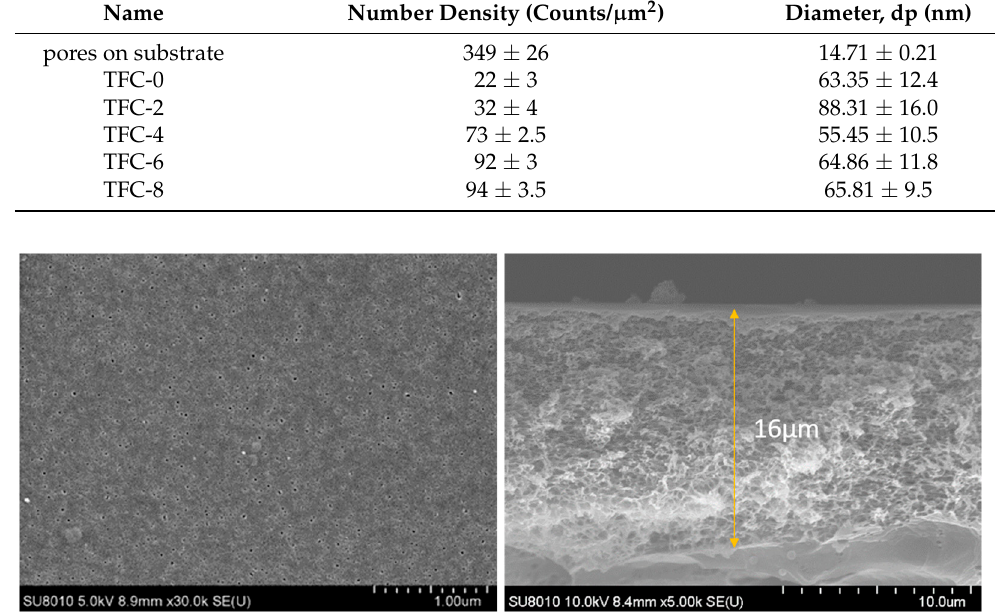
Figure 3. Surface pore size and PSF cross-section images of the substrate membrane. Table 1. Base film pore size and back opening.